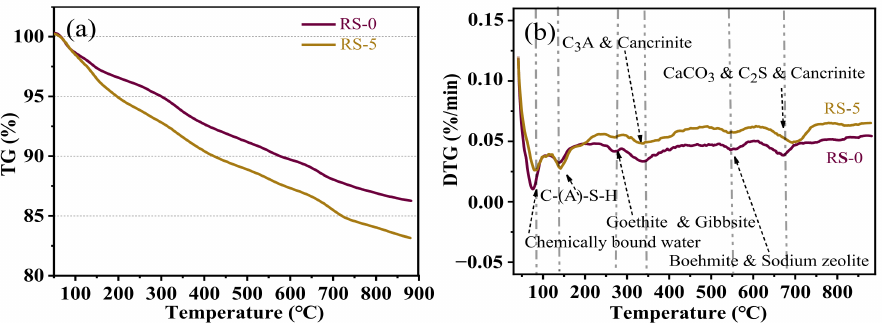
Figure 8. ( a ) The TG and ( b ) DTG curves of composite cementitious materials with different slag contents at 28